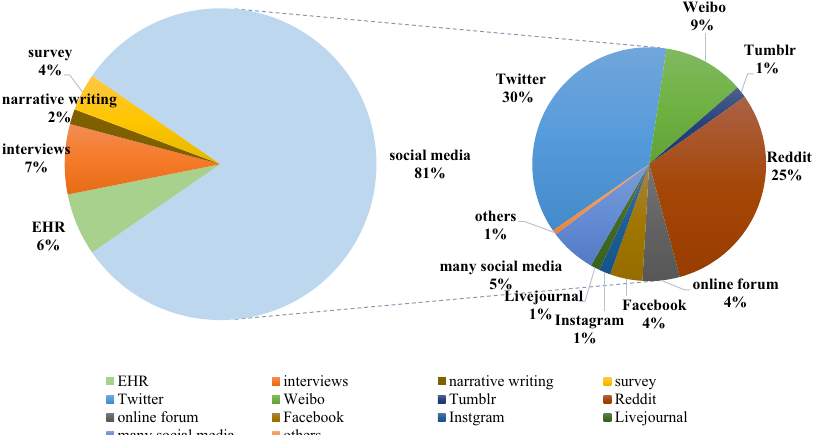
Fig. 4 Distribution of different data sources. The pie chart depicts the percentages of different textual data sources based on their